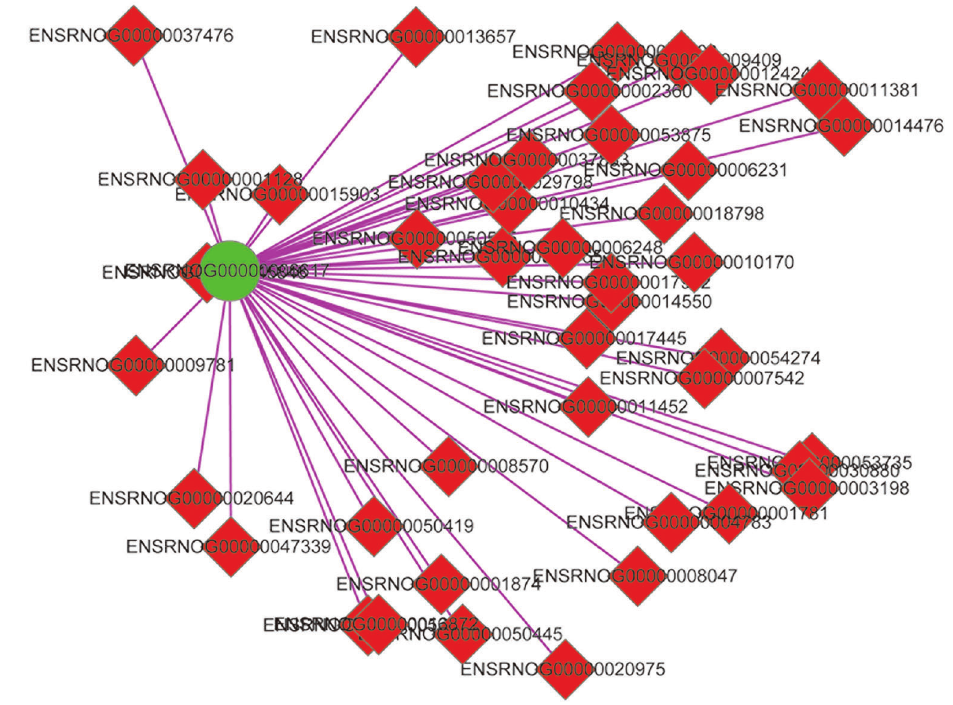
Figure 2. Co-expression network of gene rno-Cntnap2 ( ENSRNOG00000006617 ).